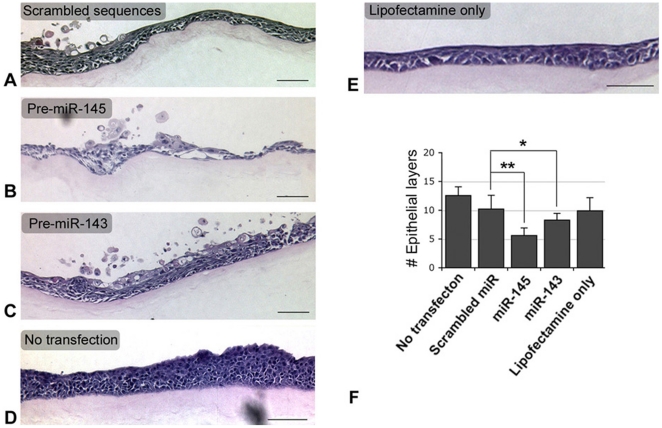
Corneal epithelial organotypic assay.Representative hematoxylin-eosin stained pictures from serial sections of cell-denuded AM composite showing the thickest epithelium and the most epithelial layers. (A) CEPCs transfected with scrambled sequences, (B) CEPCs transfected with pre-miR-145, (C) CEPCs transfected with pre-miR-143 and (D) CEPCs with Lipofectamine 2000 and (E) non-transfected CEPCs. Scale bars: 100 µm. (F) Epithelium forming efficiency determined by the number of epithelial layers in 15 sites along the composite. * P = 0.042; ** P = 0.0002 (paired Student's t-test).